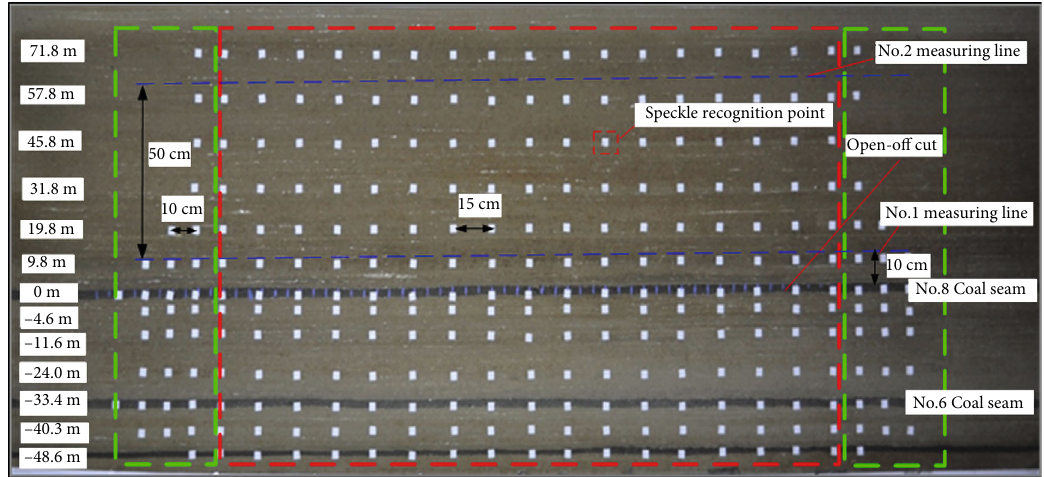
Figure 2: Layout of stress and displacement measuring